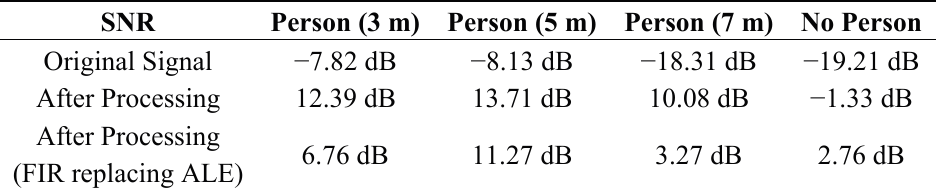
Table 1. SNR of respiration signals in different